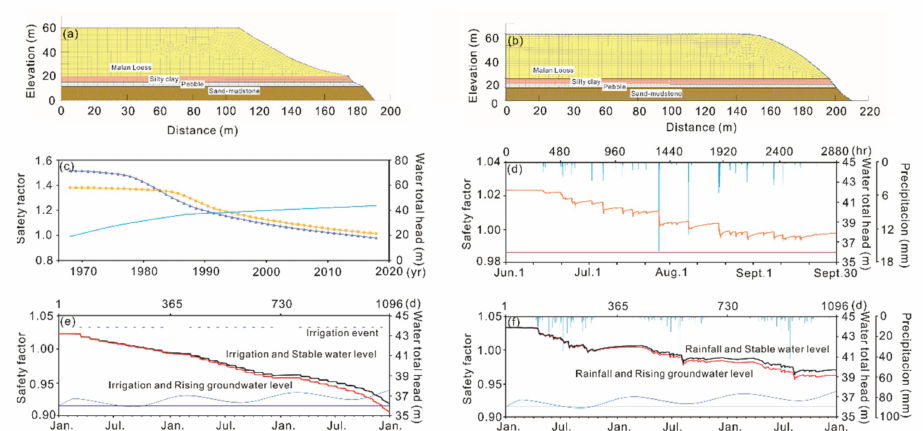
Figure 7. Results of saturated-unsaturated seepage and stability analysis: ( a , b ) numerical analysis model; ( c ). Variation in safety factor due to groundwater level change; ( d , f ) variation in safety factor due to precipitation (H1, stable water table; H2, rising water table; Fs, safety factor); ( e ) variation in safety factor due to